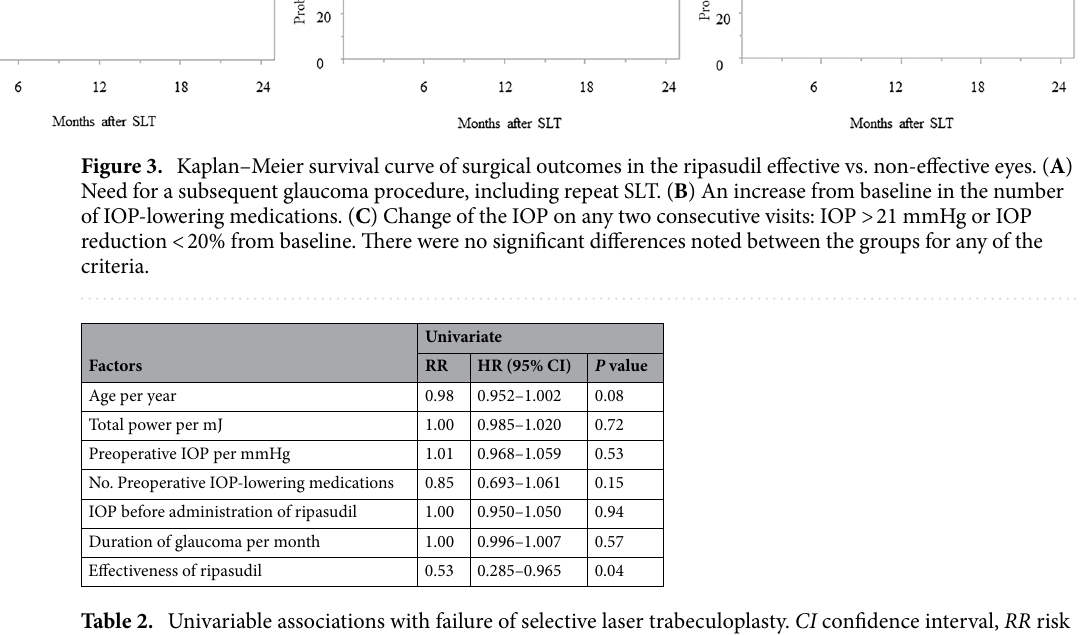
Table 2. Univariable associations with failure of selective laser trabeculoplasty. CI confidence interval, RR risk ratio, HR hazard ratio, IOP intraocular